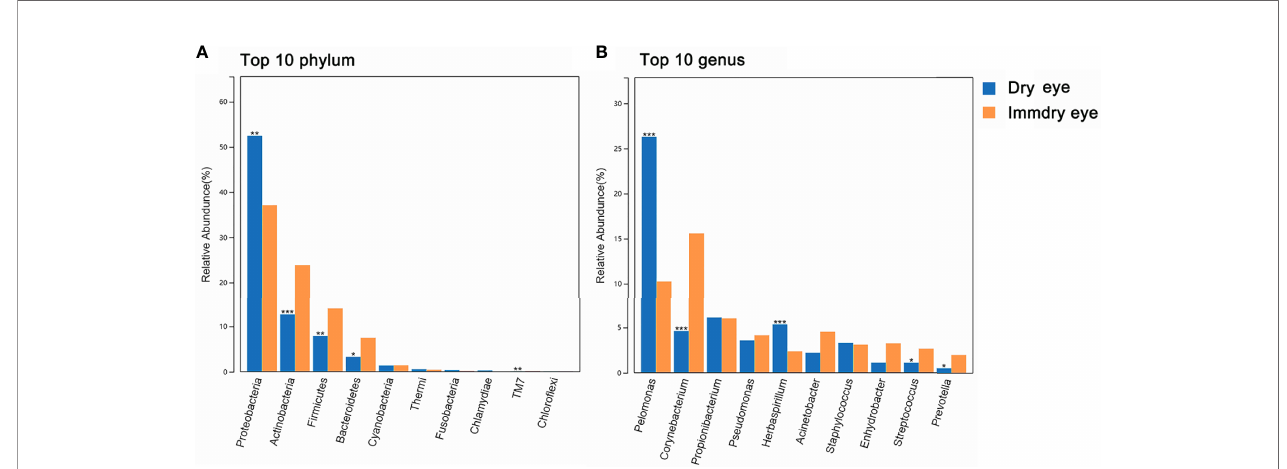
FIGURE 2 | Comparisons of the taxonomic classi fi cations between the dry eye group and the immdry eye group. (A) Top 10 phyla in the two groups. (B) Top 10 genera in the two groups. Dry eye and immdry eye subjects are indicated in blue and orange , respectively. * p < 0.05, ** p < 0.01, *** p < 0.001.